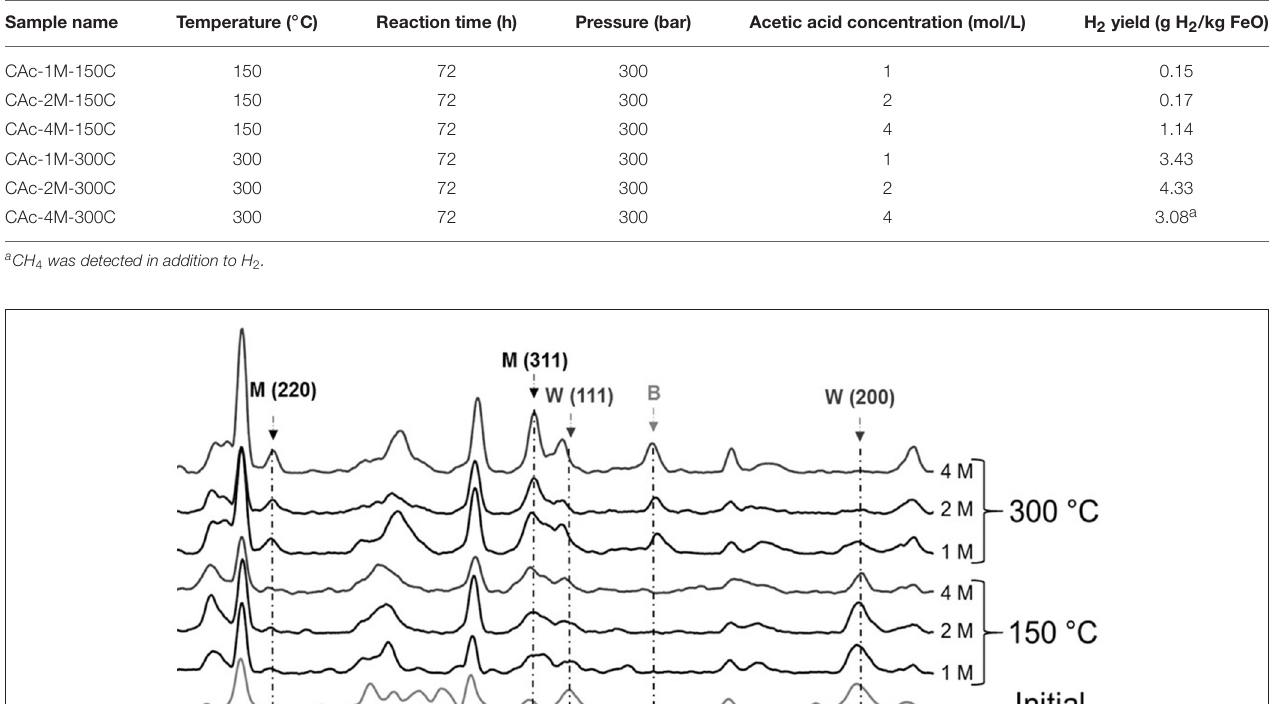
TABLE 4 | Measured hydrogen production after hydrothermal oxidation of steel slag in the presence of acetic acid; experiments were performed in gold capsules.